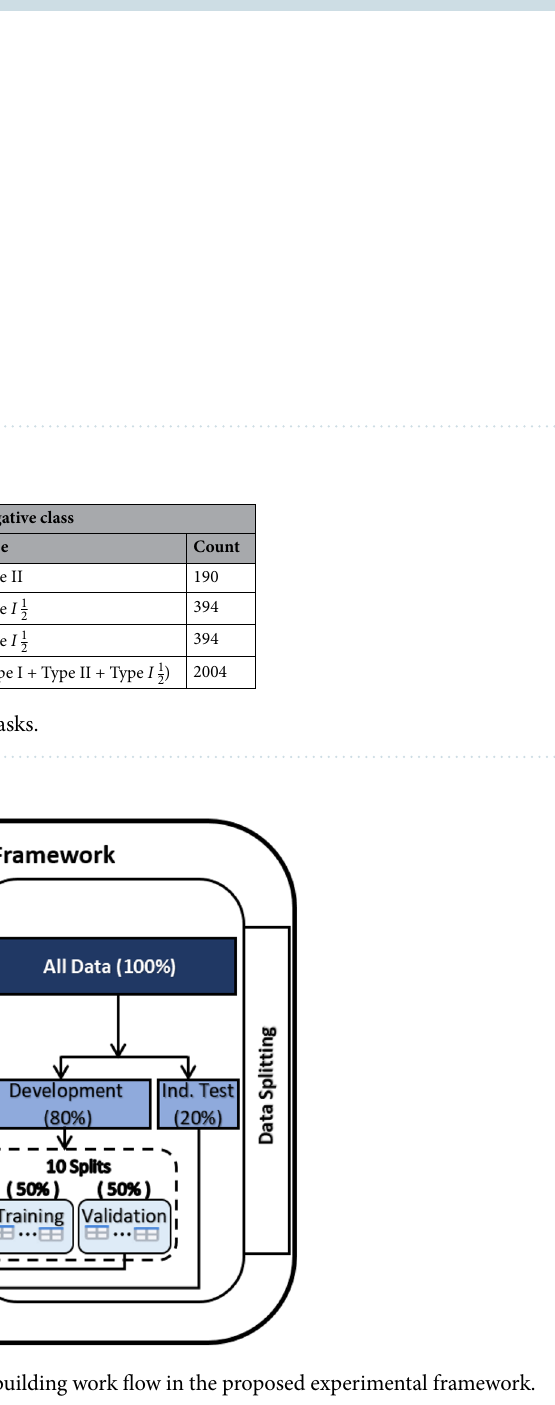
Figure 5. Data reduction and model building work flow in the proposed experimental